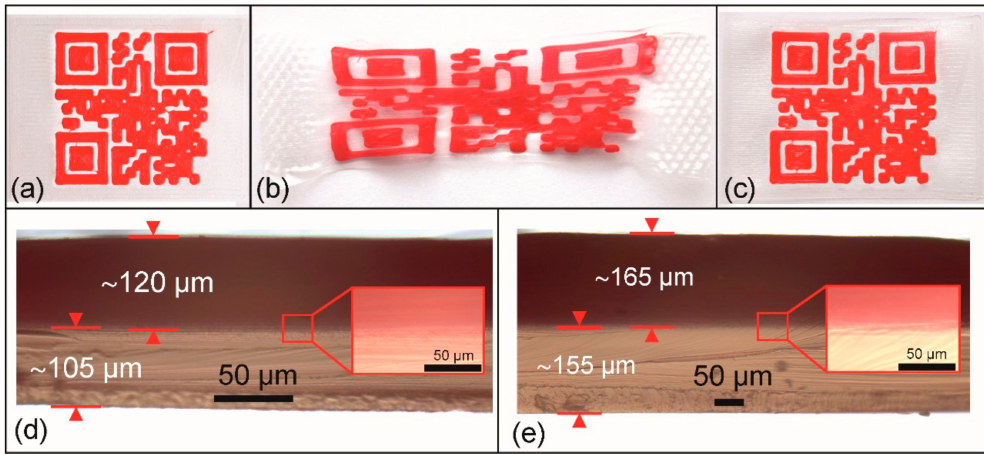
Figure 11. Type 2 QR code carrier: Permanent shape after 3D printing ( a ), initial clamping distance = 25 mm), temporary shape as obtained after 20 loading-unloading cycles (maximum clamping distance = 55 mm) at 60 ◦ C, followed by programming ( b ), and the recovered shape after heating to 60 ◦ C in the 21 st cycle ( c ). Microscopic investigation of a cut through the cuboid and the substrate as examined in the 22 nd cycle for the programmed shape ( d ) and the recovered shape ( e ); the insets show an enlarged view of the boundary between the substrate (below) and the elevation (above).